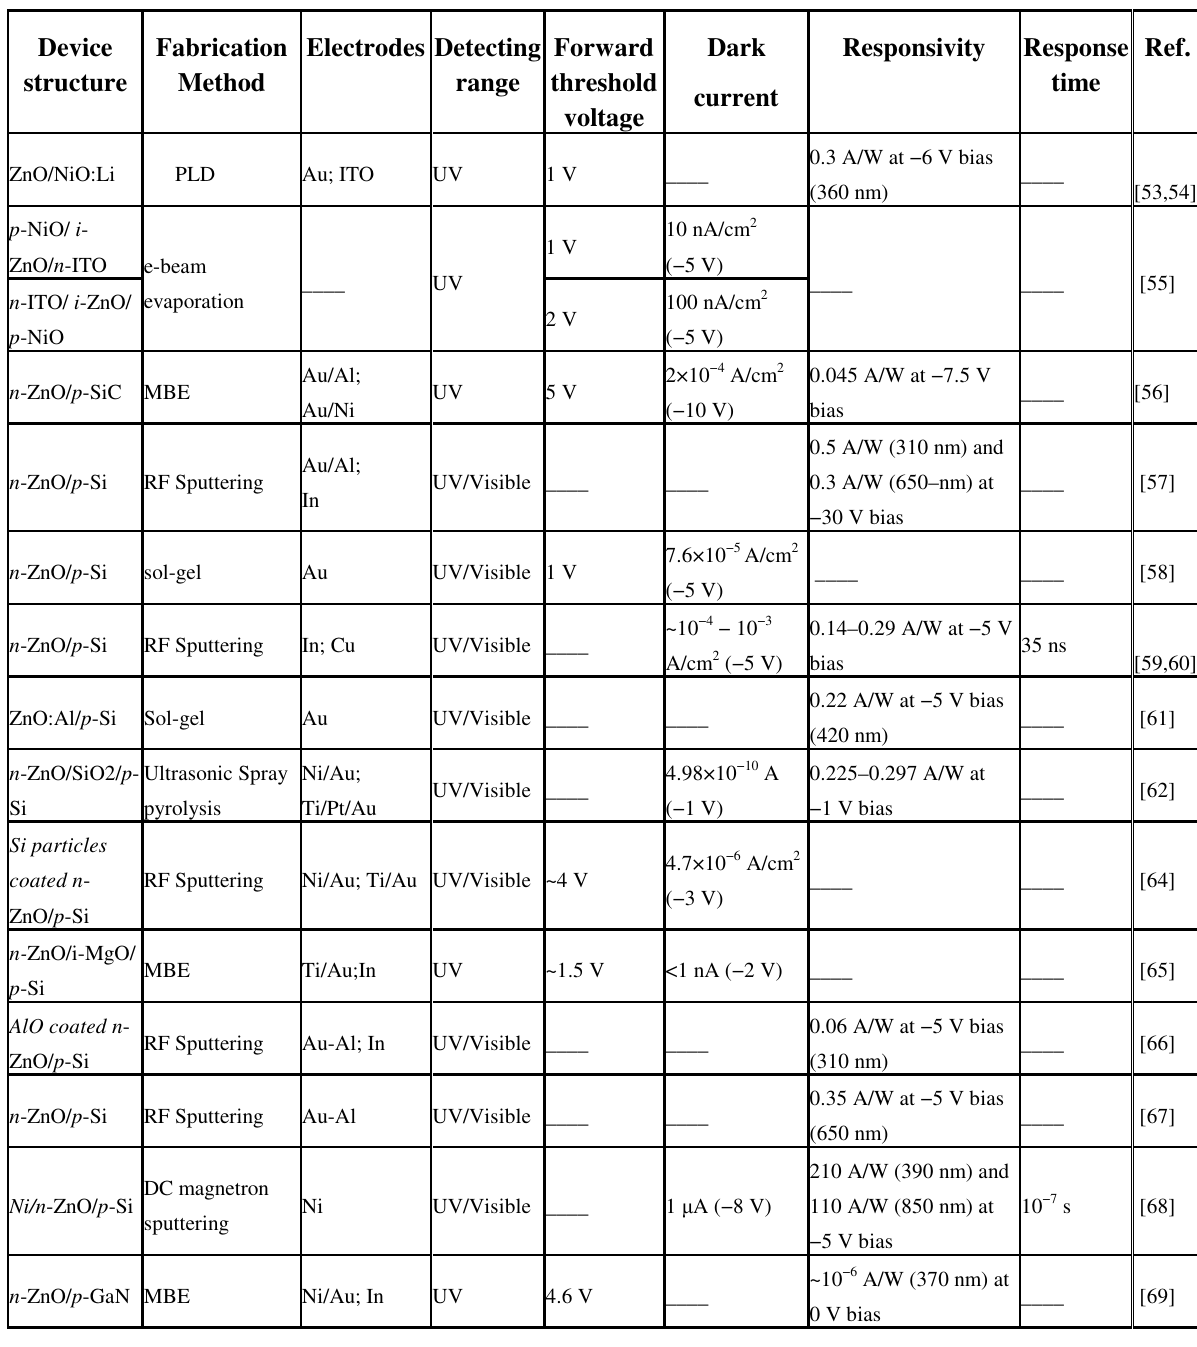
Table 2. ZnO-based p-n heterojunction